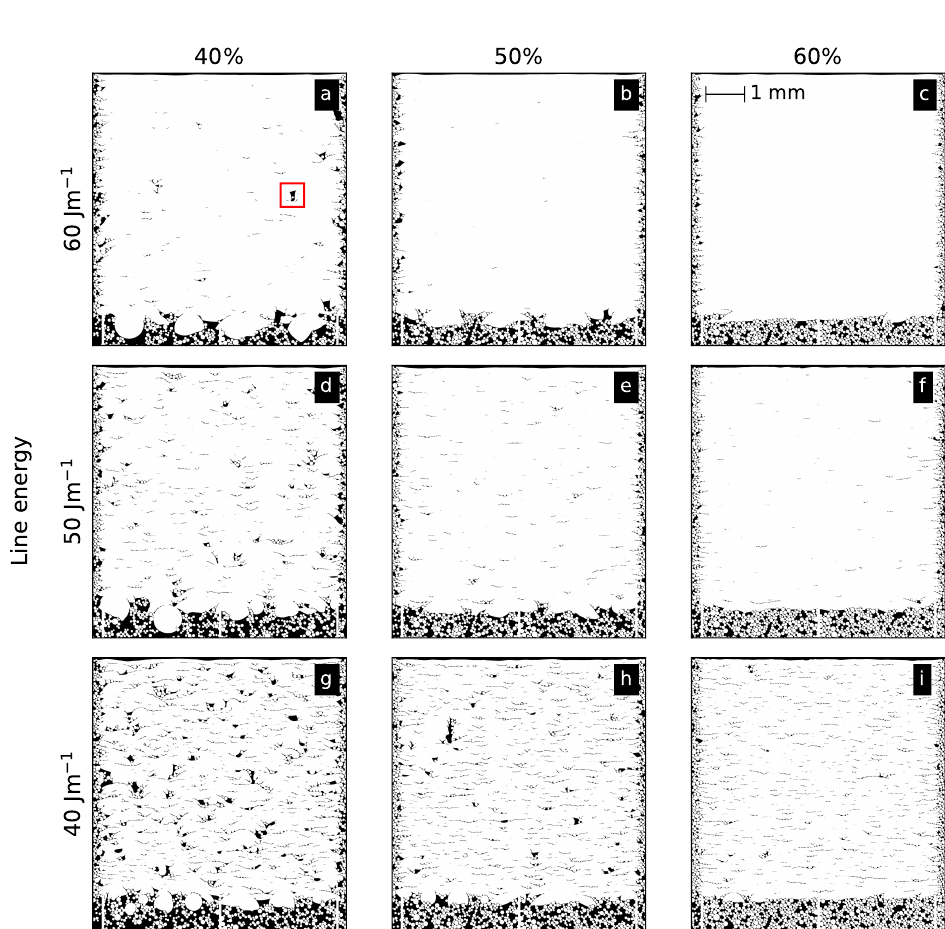
Figure 5. Numerical results for Ti-6Al-4V for powder bulk densities between 40% and 60% for a constant scan velocity of 24m/s and different line energies of 40( g , h , i ), 50( d , e , f ) and 60J/m ( a , b , c ). A multi-layer binding fault in ( a ) is highlighted for further discussion.